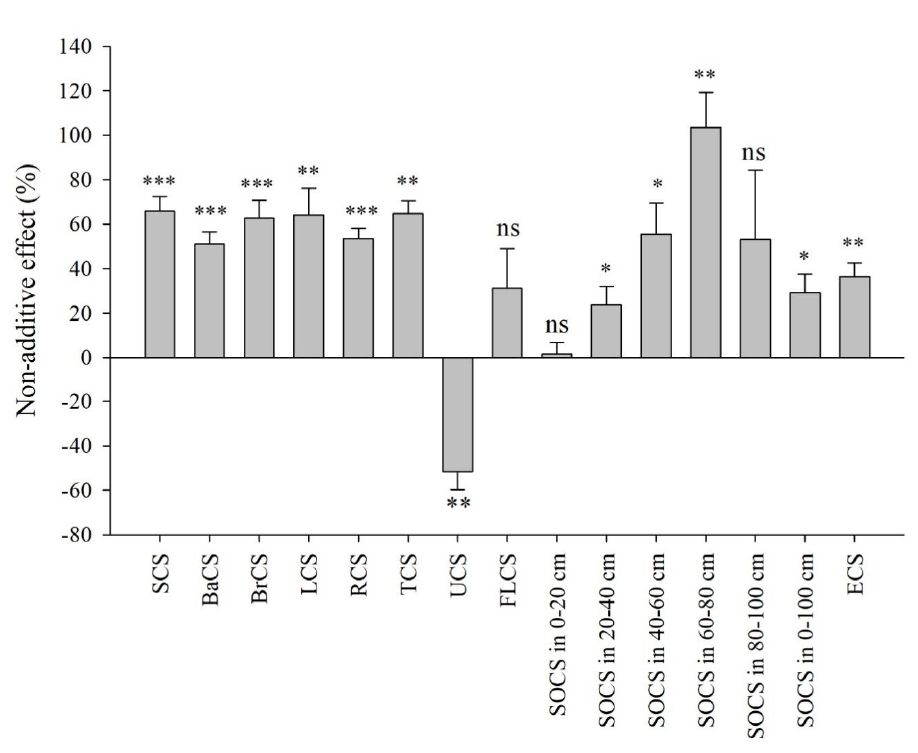
Figure 4. Non-additive effects of the mixed plantation on carbon storage (mean ± SE, n = 5) in various vegetation compartments and soil horizons. NAE values that differed significantly from zero, according to one-sample Student’s t-tests, are indicated by * ( p < 0.05), ** ( p < 0.01), or *** ( p < 0.001); ‘ns’, non-significant. SCS, stem carbon storage; BaCS, bark carbon storage; BrCS, branch carbon storage; LCS, leaf carbon storage; RCS, root carbon storage; TCS, tree carbon storage; UCS, understory carbon storage; FLCS, floor litter carbon storage; SOCS, soil organic carbon storage; ECS, ecosystem carbon storage.